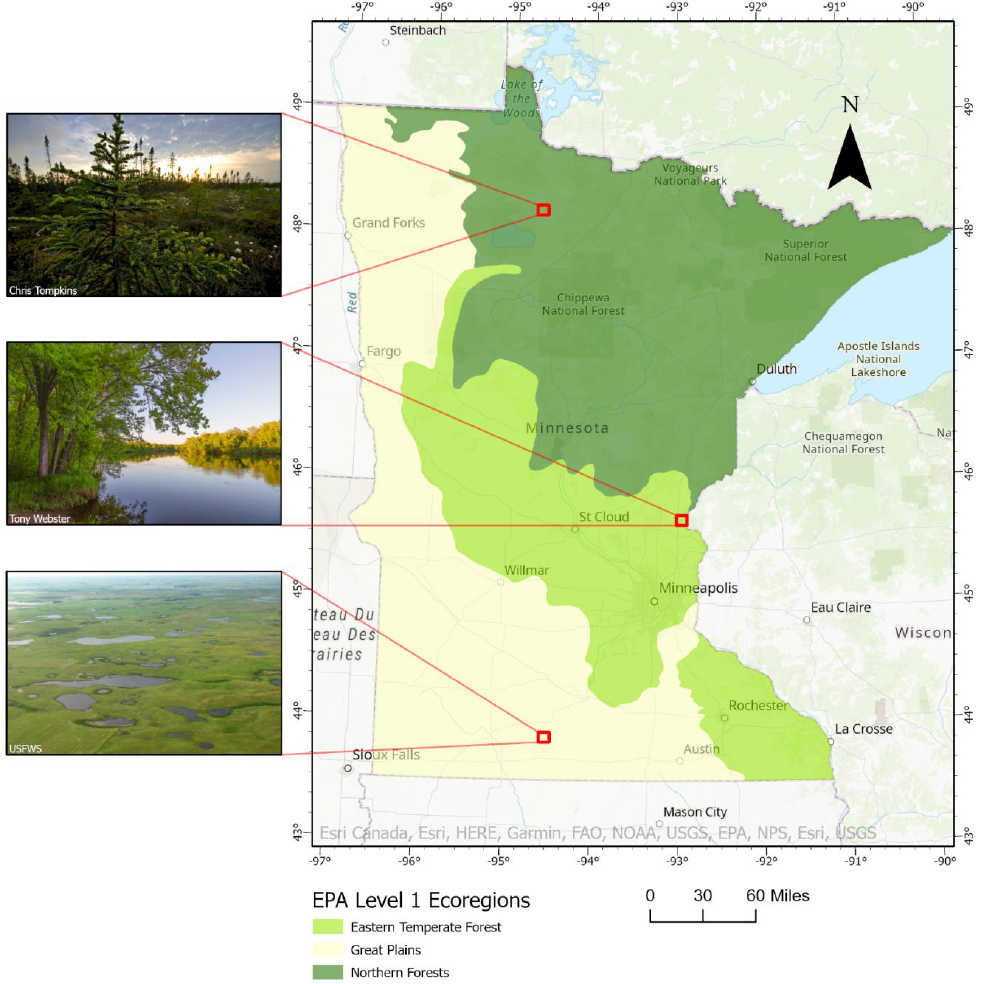
Figure 2. Ecoregions of Minnesota and their wetland types. Minnesota contains 10.6 million acres of wetland in three different ecoregions according to EPA Level 1 designations [34]. The north is dominated by coniferous forest and peatland, the central and southeast contain mixed deciduous forest with forested wetlands and lakes, and the south and west contain cultivated prairie and depressional prairie pothole